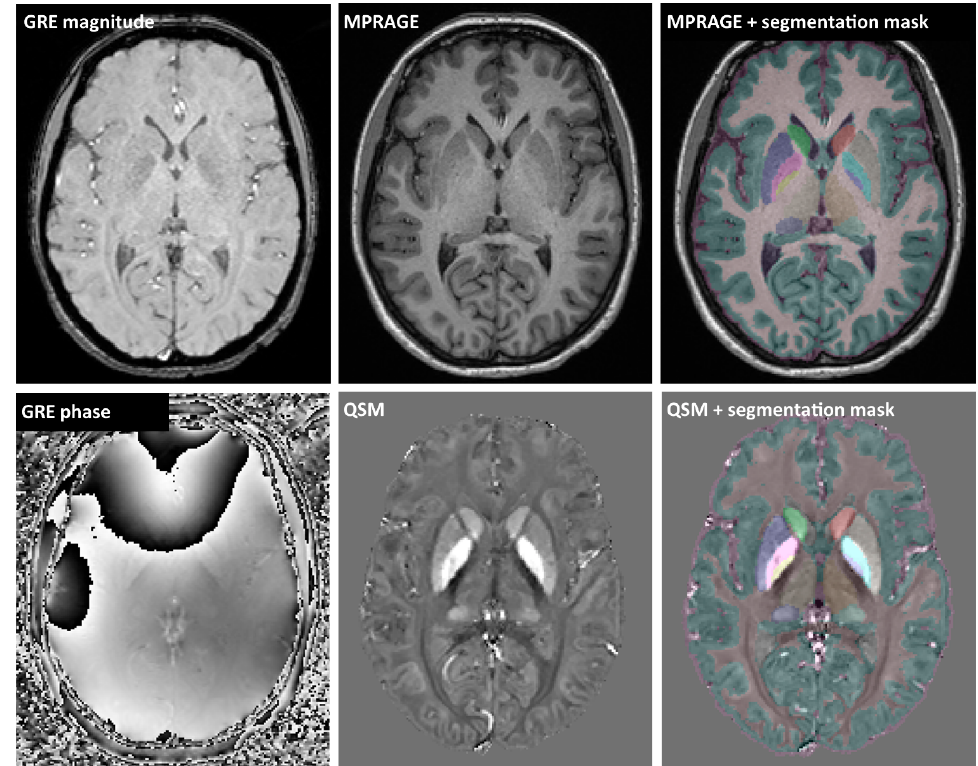
Figure 1. Example MRI images: gradient-echo (GRE) magnitude and phase images were processed to quantitative susceptibility map (QSM). Multi-atlas segmentation employed coregistered QSM and MPRAGE images to generate masks of deep grey matter structures, cerebral white and grey matter, and CSF.